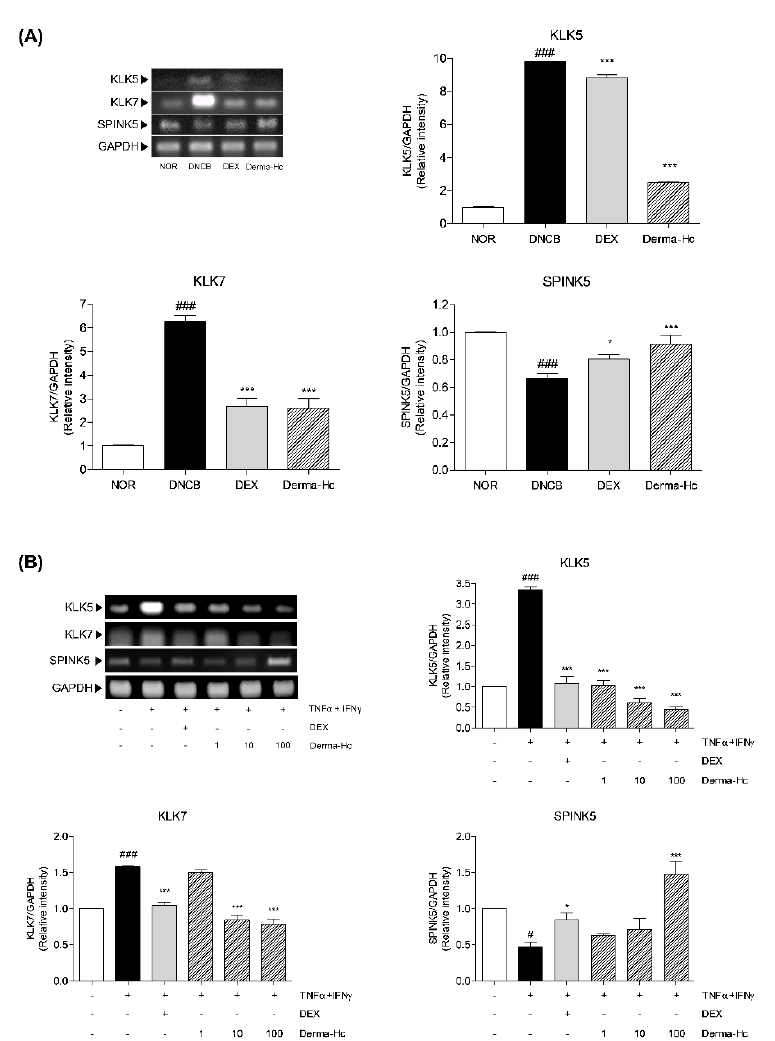
Figure 7. Derma-Hc regulates the expression levels of keratinocyte differentiation-related factors in ( A ) DNCB-induced mice and ( B ) TNF- α +IFN- γ -treated human keratinocytes. NOR, Normal saline-treated group; DNCB, 2,4-dinitrochlorobenzene (DNCB)-sensitized group; DEX, DNCB-sensitized and dexamethasone-treated group. The mRNA levels of kallikrein-related peptidase 5 (KLK5), kallikrein-related peptidase 7 (KLK7) and serine protease inhibitor Kazal-type 5 (SPINK5), were analyzed by RT-PCR. Three repeats of an experiment were conducted. The data are presented as mean ± standard error of the mean. # p < 0.05 and ### p < 0.001 compared to NOR group. * p < 0.05 and *** p < 0.001 compared to individual groups.